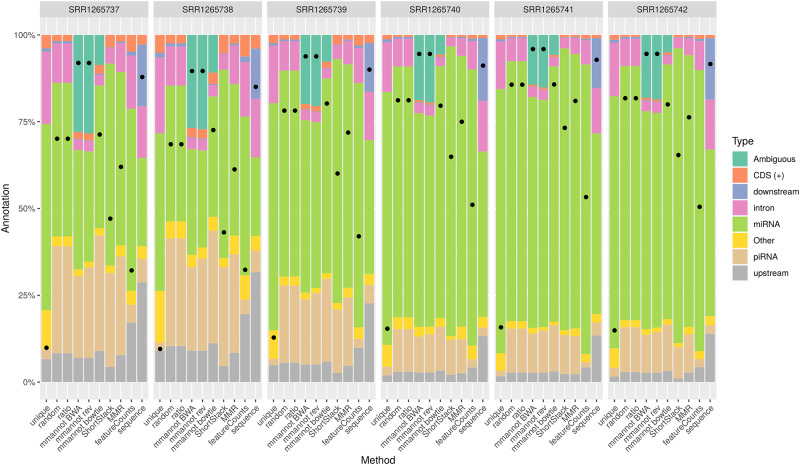
Comparison of the different strategies on the D. rerio data sets.See Fig 2 for a legend of the plot.